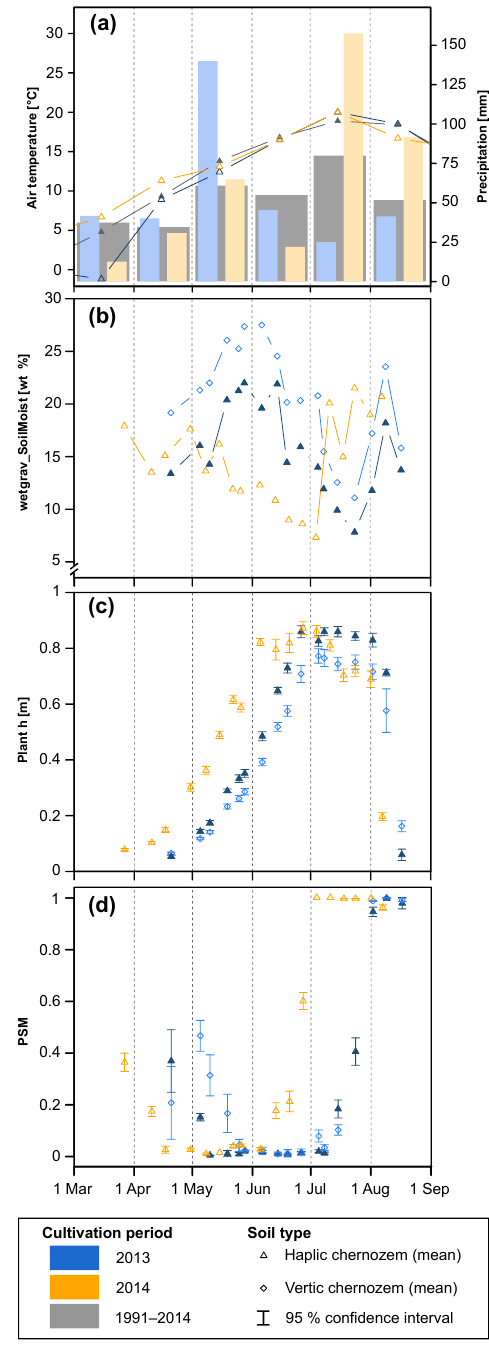
Figure 4. Comparison of meteorological conditions, soil moisture, and vegetation parameters characterizing spring wheat (cultivar: Taifun) in 2013 and 2014: (a) monthly mean air temperature and monthly rainfall; (b) gravimetric soil moisture ( wetgrav_SoilMoist ); (c) plant height ( Plant h ); and (d) proportion of senescent material (PSM). Air temperature and rainfall were recorded at the Dachwig meteorological station (DWD,